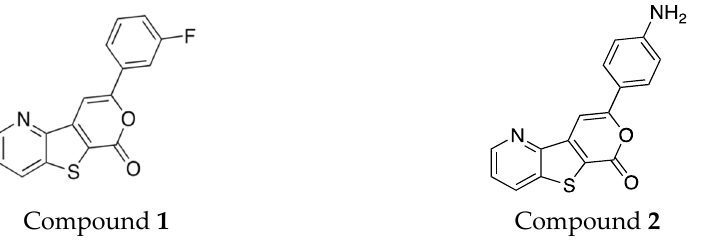
Figure 1. Structure of the tricyclic lactone derivatives of thienopyridine.